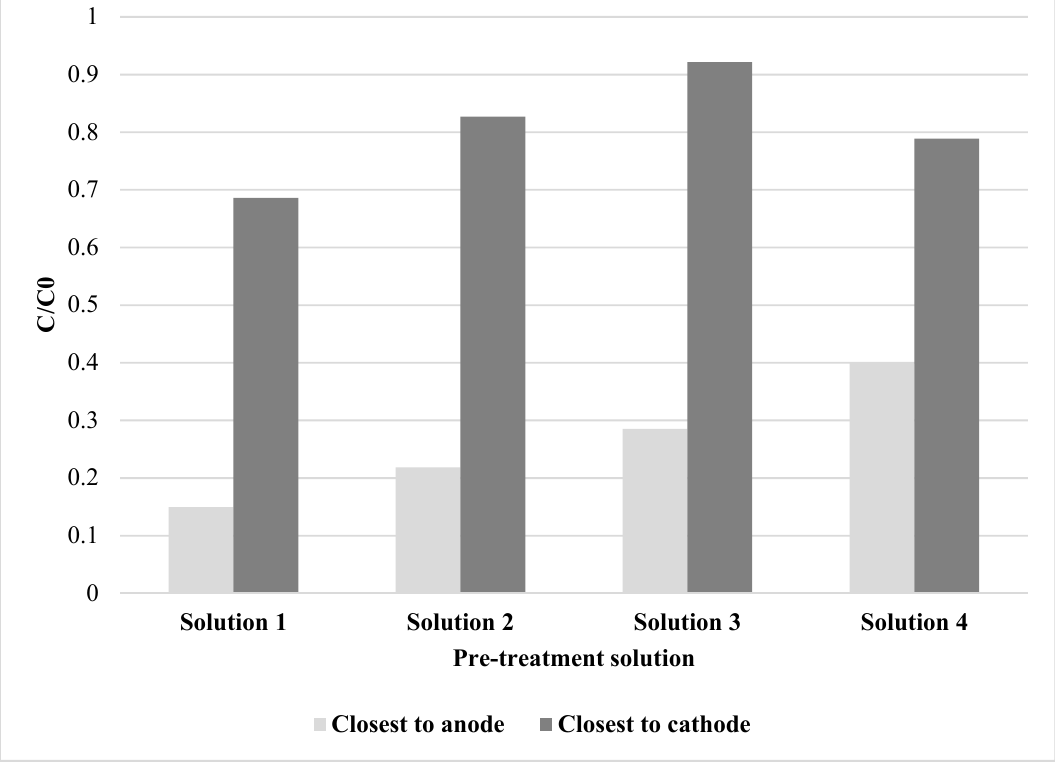
Figure 1. C/C 0 ratio of copper concentration for slices closest to anode and closest to cathode for different pre-treatment solutions after electrodialytic remediation.